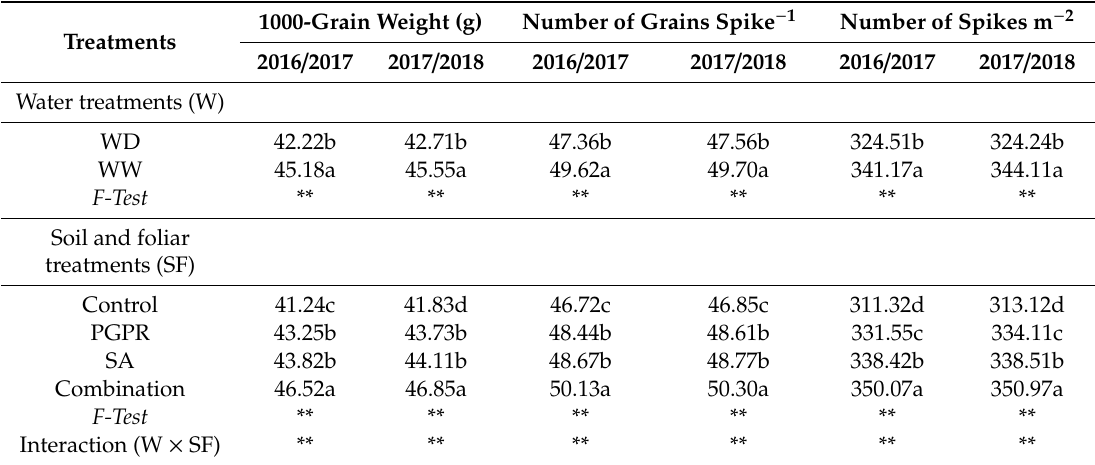
Table 6. Yield traits of wheat as a ff ected by PGPR, SA, and their combination in 2016 / 2017 and